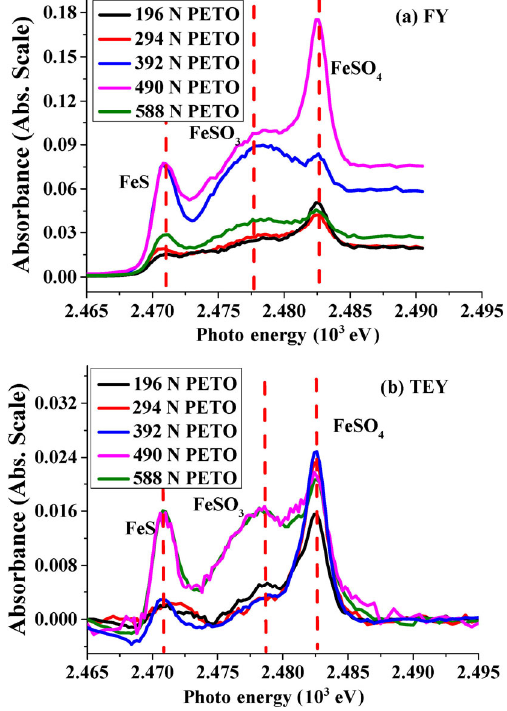
Fig. 3 Sulfur K-edge FY mode (a) and TEY mode (b) XANES spectra for DPS-tribofilm with different applied